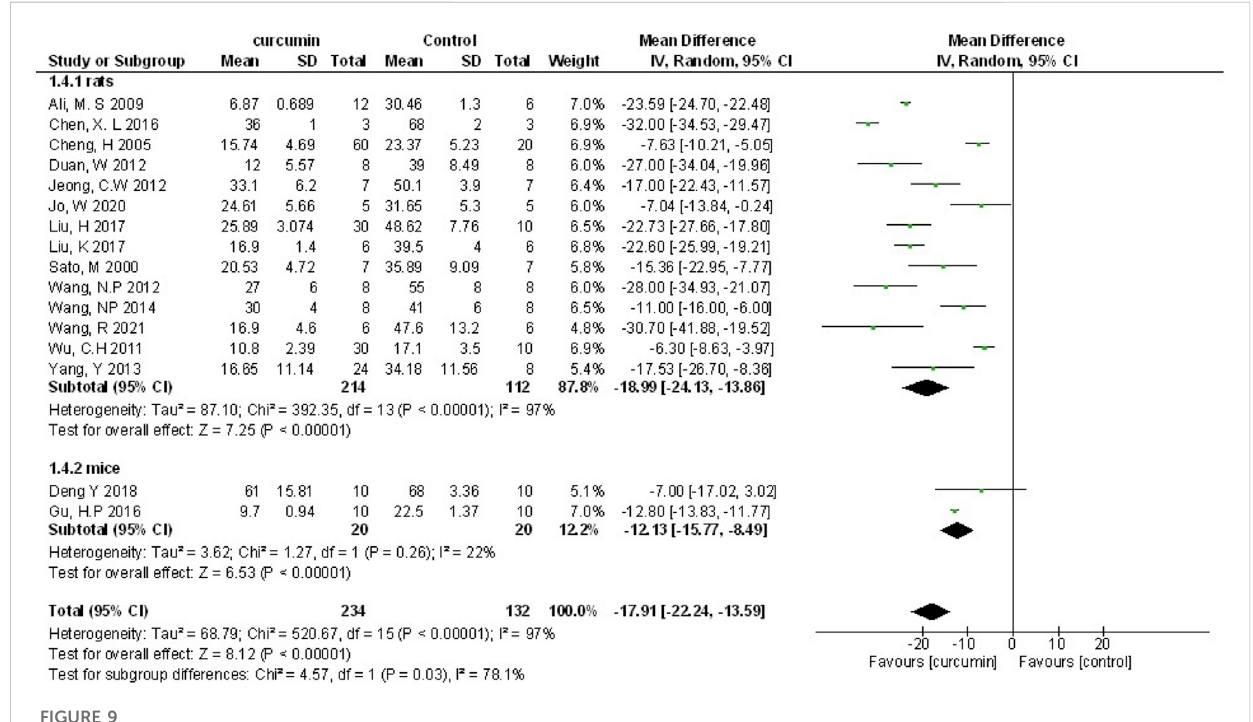
The subgroup analysis (genus of experimental animals) of curcumin on MI size.